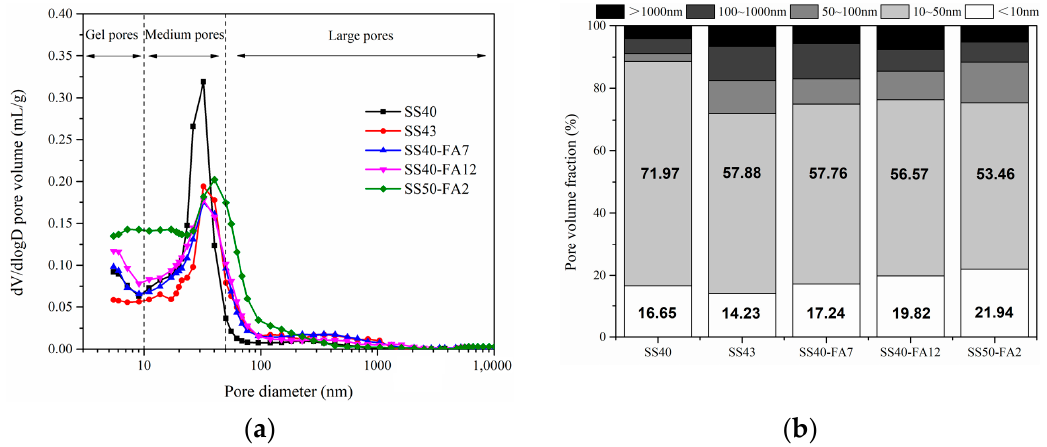
Figure 9. ( a ) Pore size distribution curves and ( b ) pore volume fractions of SS-based composite cementitious materials at 90 days. Table 3. Pore parameters of SS-based composite cementitious materials at 90 days. Groups